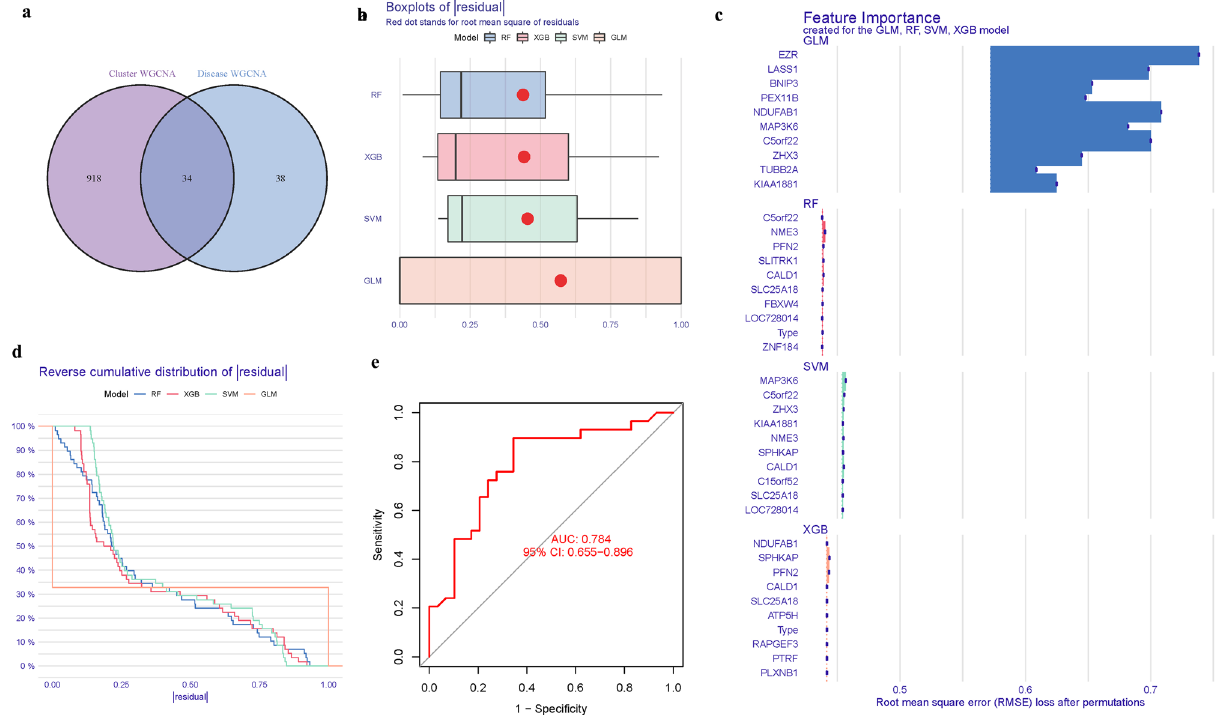
Figure 9. ( a ) Identification of GlnMgs with a venn diagram. ( b , c ) Residuala˘expression patterns. ( d ) AUC of train group. ( e ) AUC of test group.